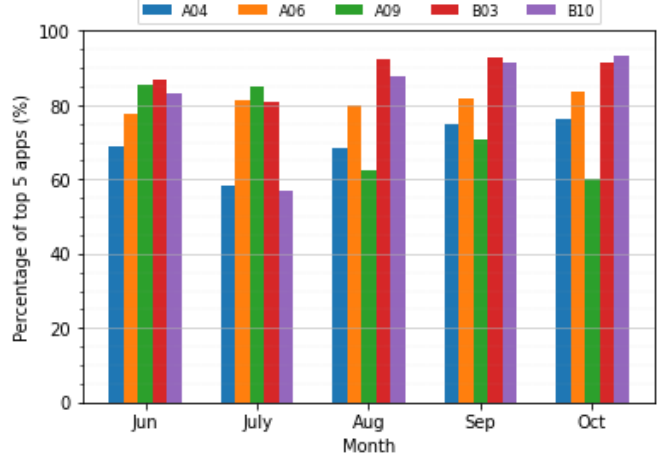
Figure 3. Top five apps usage percentage from June to